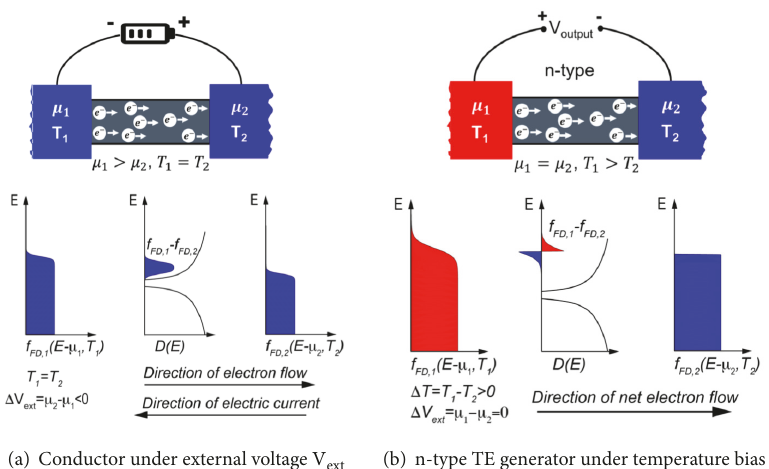
Figure 3: Origin of electricity under an external electrical bias (voltage) and thermoelectricity under a temperature bias. (a) A typical elastic conductor in the Landauer-Datta-Lundstrom model, in which a voltage V ext is exerted by an external power source, e.g., battery. An electric current is resulted from the external electric bias, owing to the mismatch between the Fermi-Dirac distributions of the two contacts. (b) Schematic of an n-type thermoelectric generator consisting of two contacts maintained at different temperatures. The temperature bias causes a difference in the shape of the Fermi-Dirac distributions at the two contacts, thus leading to